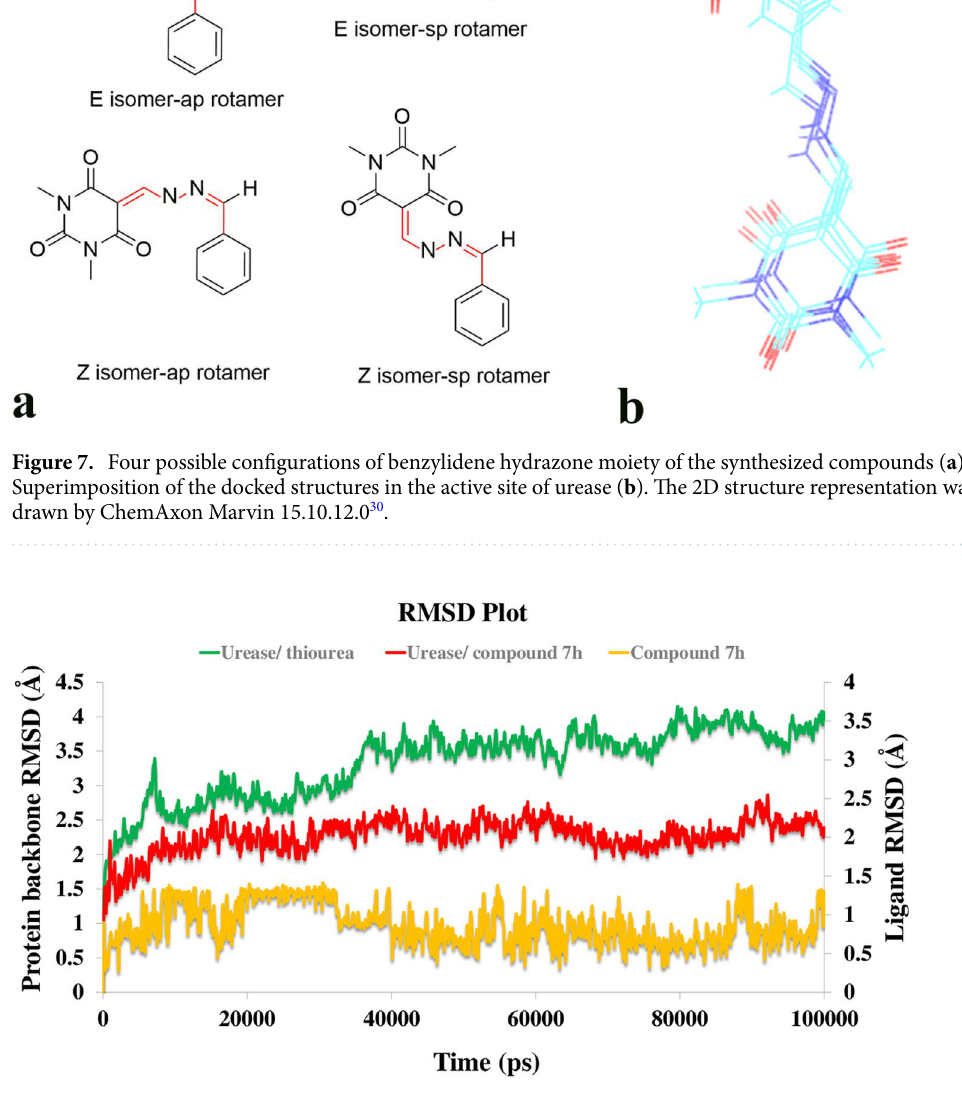
Figure 8. RMSD representation of the compound 7h (in yellow) and urease backbone in complex with thiourea (in green) and in complex with compound 7h (in red) for over 100 ns MD simulation time. The plot in was generated using Microsoft Excel (https:// www. office.